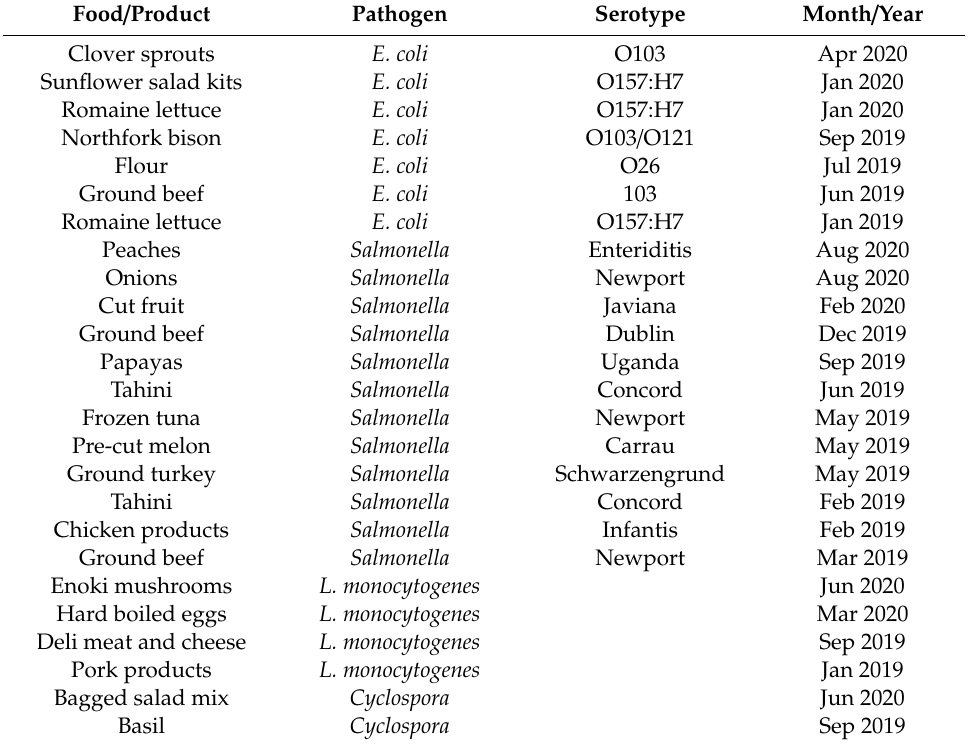
Table 1. Multi-state food borne infectious disease outbreaks in the US between January 2019